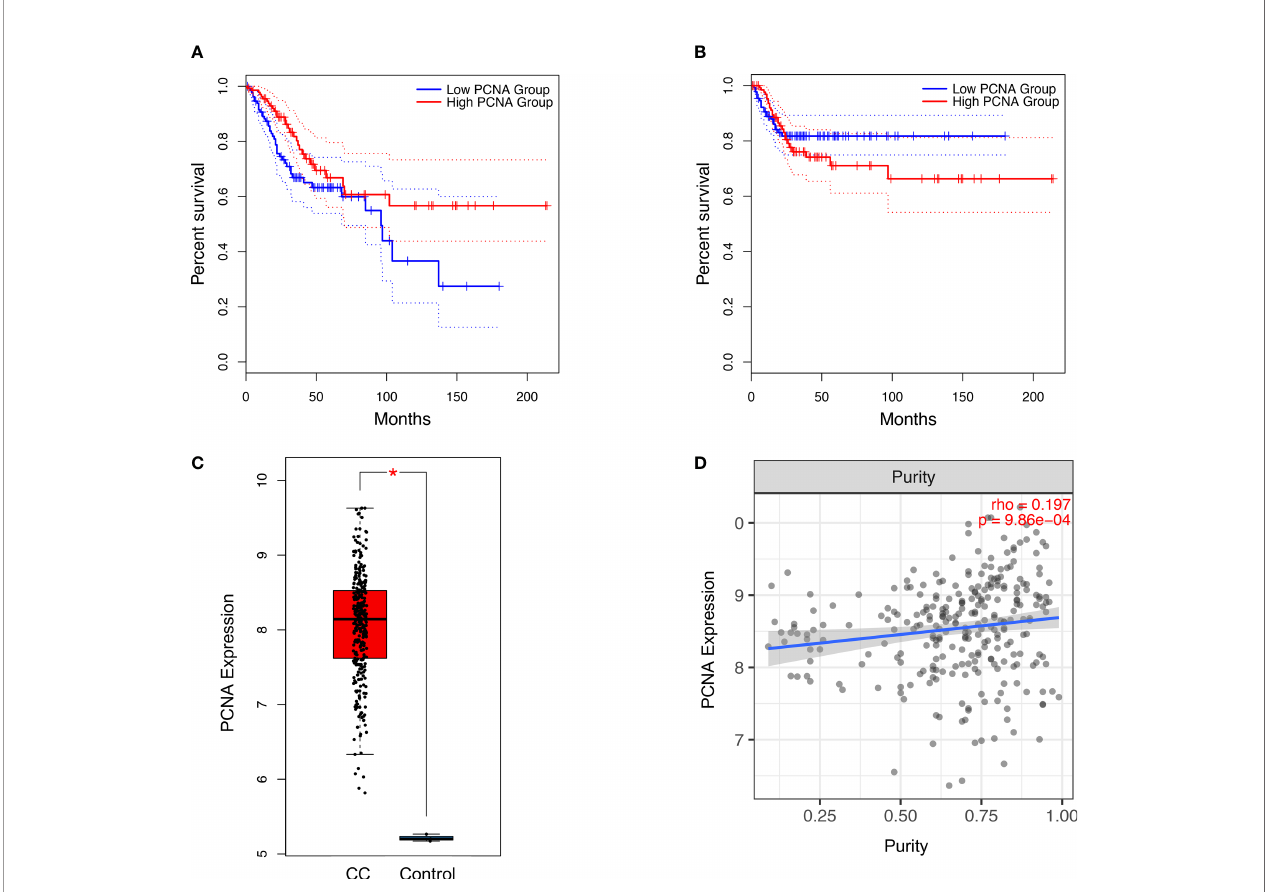
FIGURE 4 | Association of PCNA expression with (A) overall survival (log-rank P=0.022, n(high)=146, n(low)=146) and (B) disease-free survival (log-rank P =0.55, n(high)=146, n(low)=146) in CC patients. Signi fi cance was determined using a log-rank P<0.05. Overall expression (C) (transcripts per million) of PCNA based on the TCGA in patients with CC. Signi fi cance was determined using a P<0.05 and |log 2 fold change|>2. Association between expression level of PCNA and (D) tumour purity in patients with CC. Estimation was determined using the partial Spearman ’ s correlation (rho). CC, Cervical Cancer; PCNA, Proliferating cell nuclear antigen; TCGA, The Cancer Genome Atlas. *P <